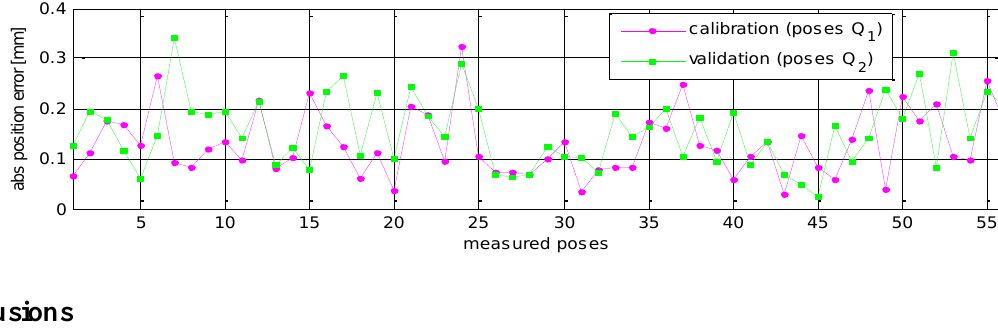
Figure 14. Absolute position accuracy at calibration poses Q